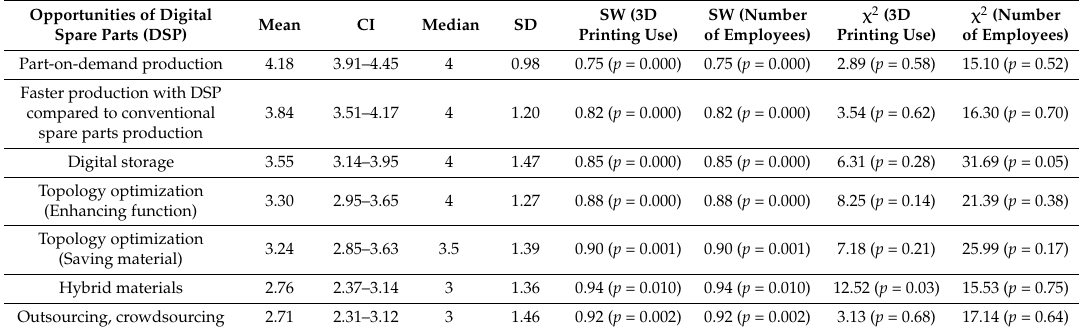
Table 6. Ranked opportunities of DSP, N = 50; CI = confidence interval, SD = standard deviation, SW = Shapiro Wilk, χ 2 = Chi-squared